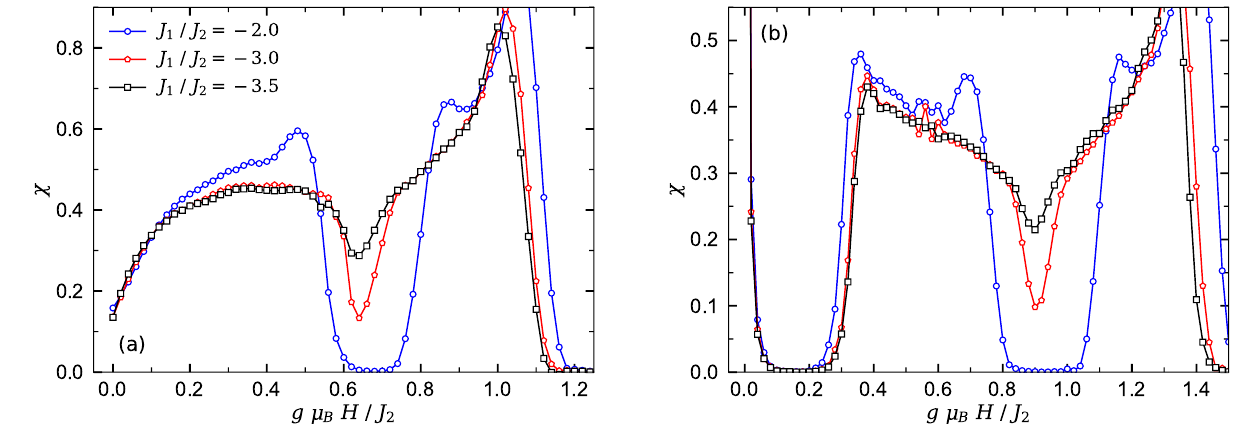
Figure 4. The low-temperature susceptibility χ versus magnetic field for ( a ) the Heisenberg branched chain Υ 2 and ( b ) chain Υ 3 , at k B T / J 2 = 0.02 under the condition (II). Three different values of